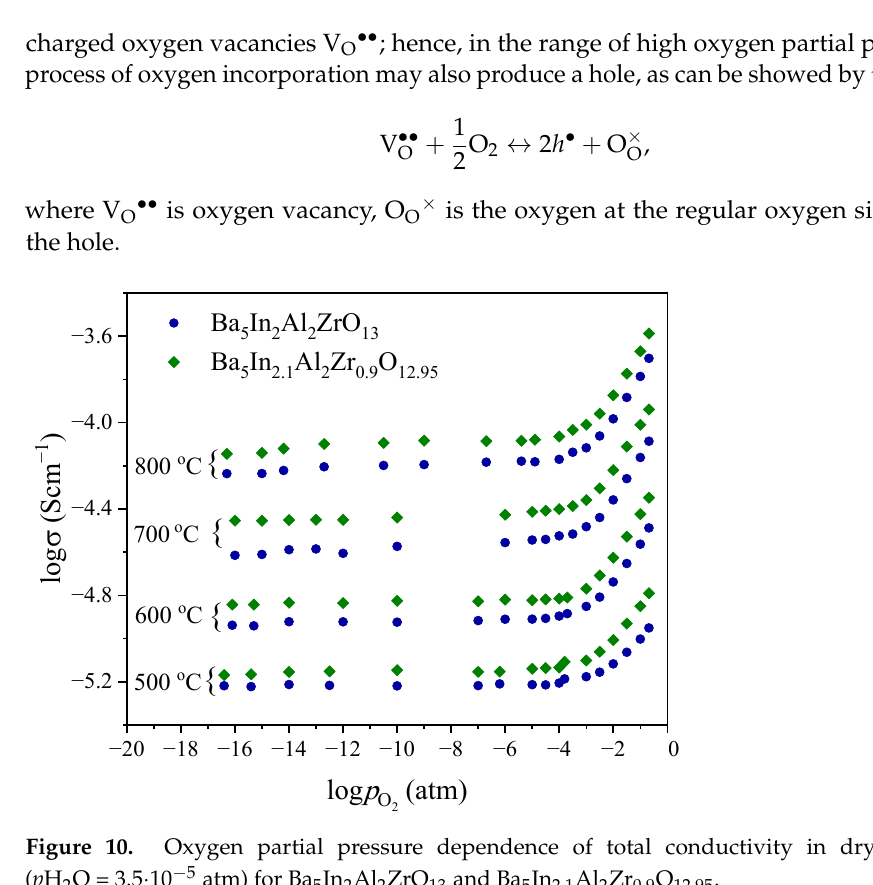
Figure 10. Oxygen partial pressure dependence of total conductivity in dry atmosphere ( p H 2 О